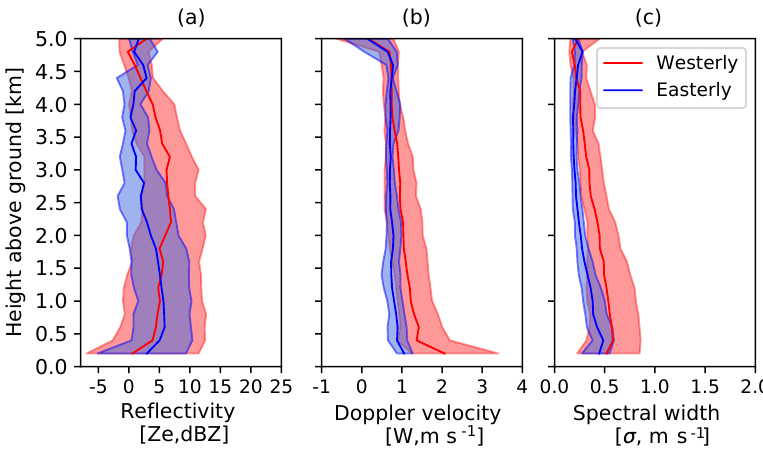
Figure 13. MRR2 profiles with height (above ground level) associated with both westerly (downslope) and easterly (upslope) flow events over the March–April 2015 period. (a) is equivalent reflectivity ( Z e , dBZ), (b) is Doppler velocity ( W , ms − 1 ) and (c) is spectral width ( σ , ms − 1 ). The height is above the radar and data from the first 200m are not used to eliminate surface-induced noise. The colour shading is the region bound by the 25th and 75th percentiles. The median is the bold line.